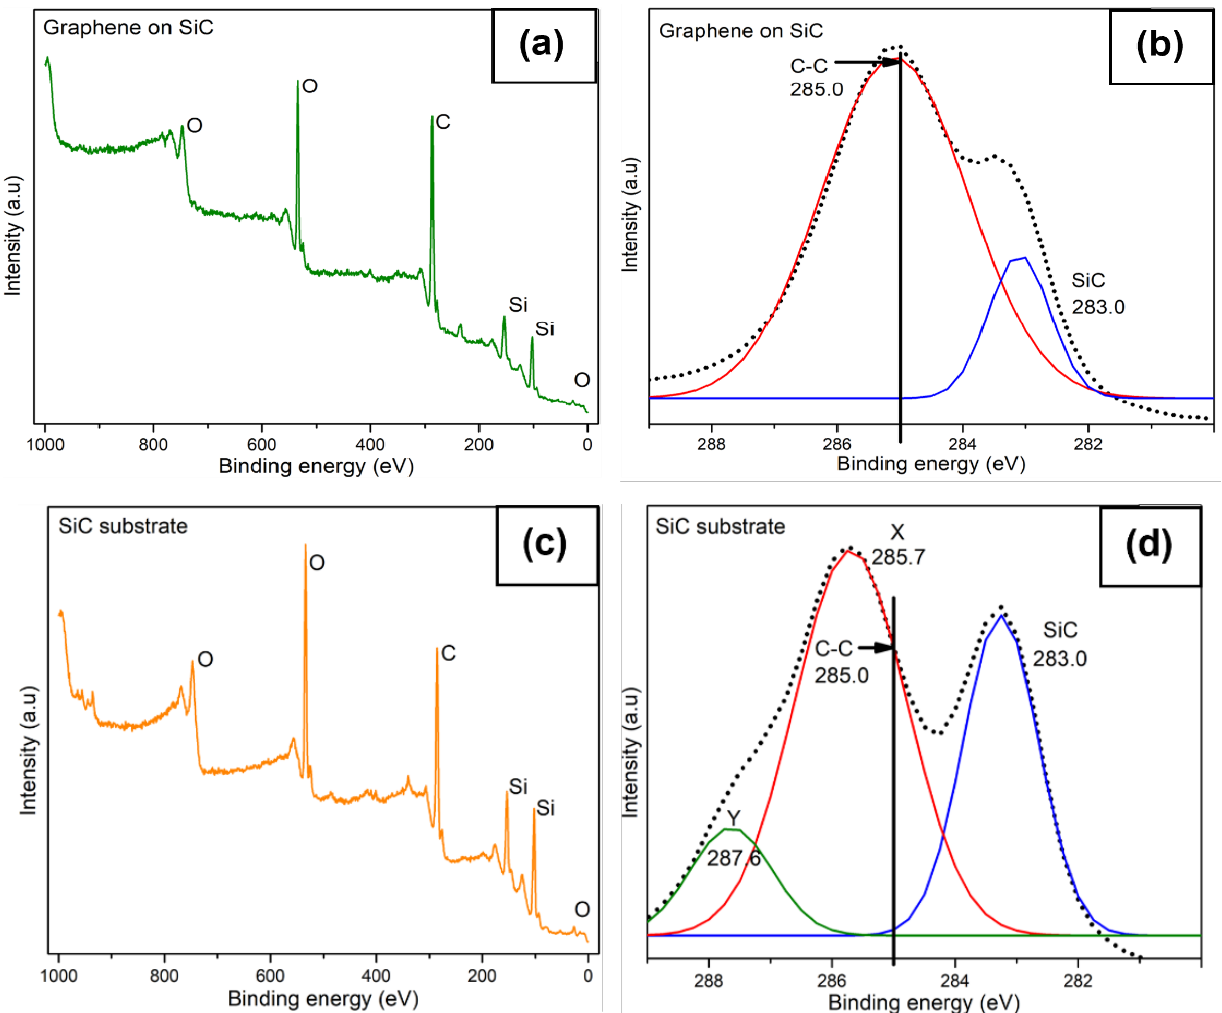
Figure 7. XPS measurements of full composition spectra ( a ) and carbon peak ( b ) after deconvolution of graphene on SiC, respectively; ( c , d ) correspond to the same but for the bare SiC substrate prior to deposition of graphene.